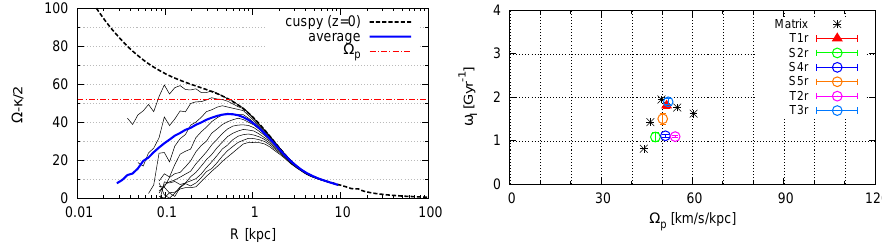
Fig. 3. The basic model ( z d = 300 pc). Left-hand panel: The precession curves for particles with different elevation above the plane (each thin solid curve is calculated for particles in the ∆ z = 50 pc wide layer starting from z = 0), and average Ω pr (the thick solid curve). The dashed line shows the cuspy profile in the equatorial plane and the dash-dotted line shows the bar pattern speed obtained in rigid halo/bulge simulations. Right-hand panel: The asterisks show the eigenmodes obtained with the matrix method and other symbols show N -body eigenmodes (prefix ‘S’ is for Superbox, ‘T’ – for tree-